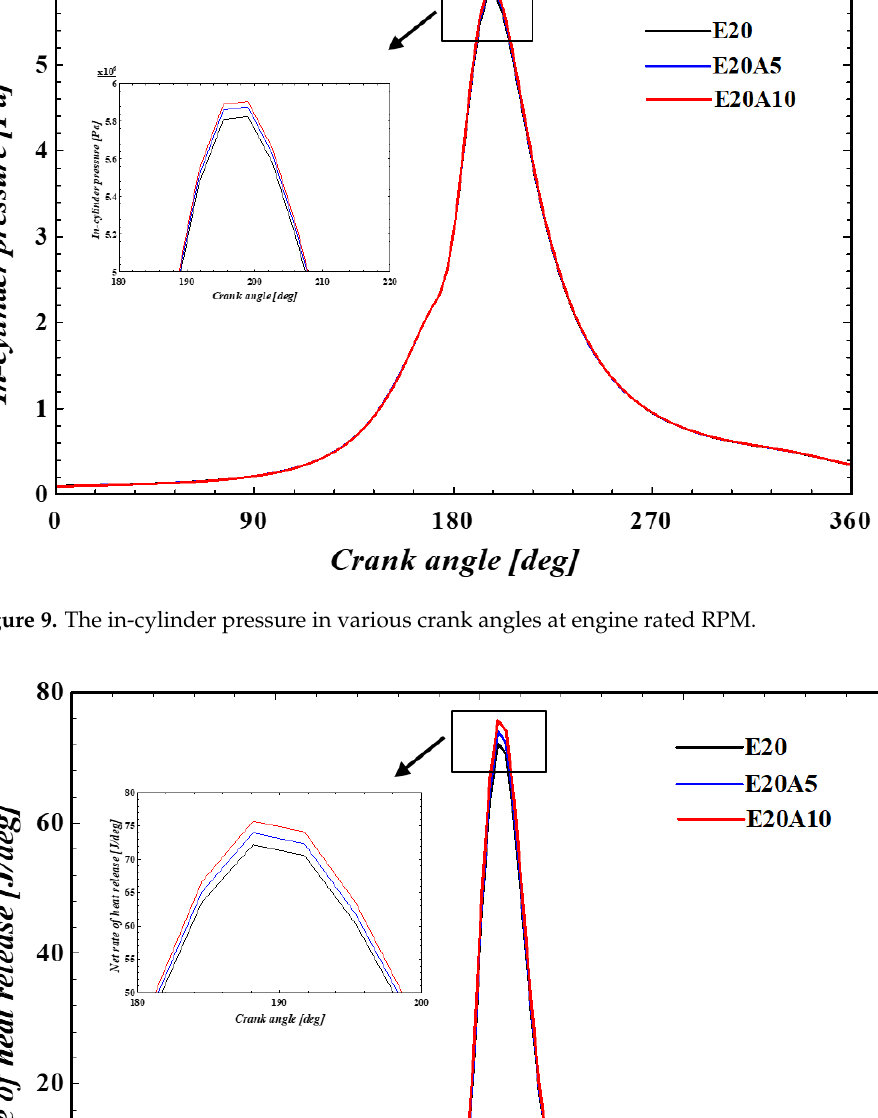
Figure 8. The energy shares of fuel energy converted to brake power and friction, and that wasted at engine rated RPM